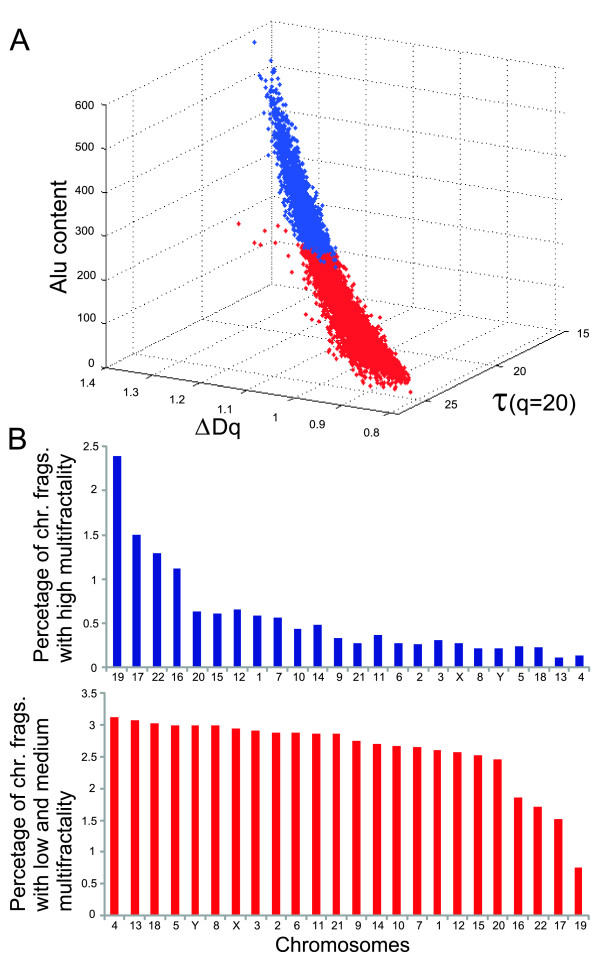
Genomic location of the most multifractal chromosome fragments: A: Discrimination method based on three parameters. Each chromosome fragment dataset is characterized by three quantities. The first quantity (x-axis) is the MD for each chromosomic fragment. The second quantity (y-axis) is the density of Alu content of the chromosomic fragments. The third quantity (z-axis) is the correlation coefficient τ(q). Blue color indicates those fragments with ΔDq ≥ 1.159 and Alu contents ≥ 217.9. B: Above, distribution for chromosome fragments with high multifractality and below, for fragments with LMM.